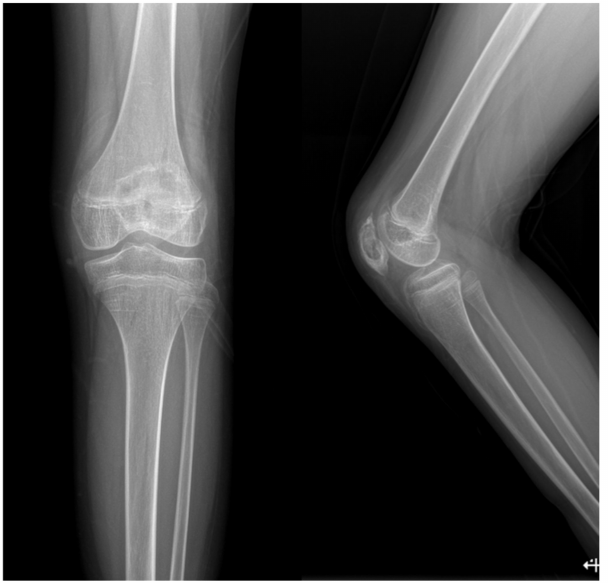
Figure 5. Preoperative simple radiograph of the left knee showed irregular sclerotic change in the posterior cortex of the patellar